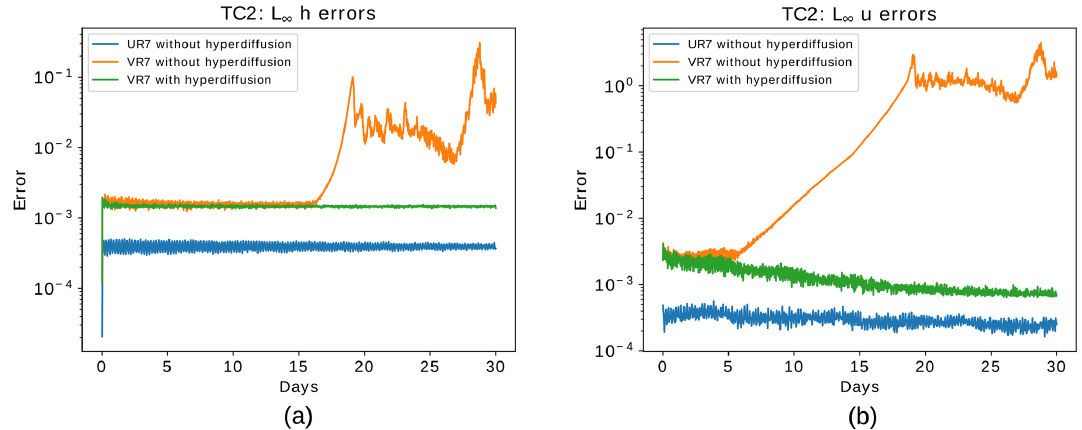
Figure 5. Steady geostrophic flow test case: time evolution of relative error in the L ∞ norm for the height field (a) and the normal component of the velocity field (b) . The blue lines indicate the errors for the UR7 grid, while the orange lines show the error for the VR7 grid with refinement based on topography, and the green lines show the error for the same VR7 grid but adding numerical fourth-order hyperdiffusion based on the alignment index with K max = 10 12 m 4 s − 1 in the shallow-water model.